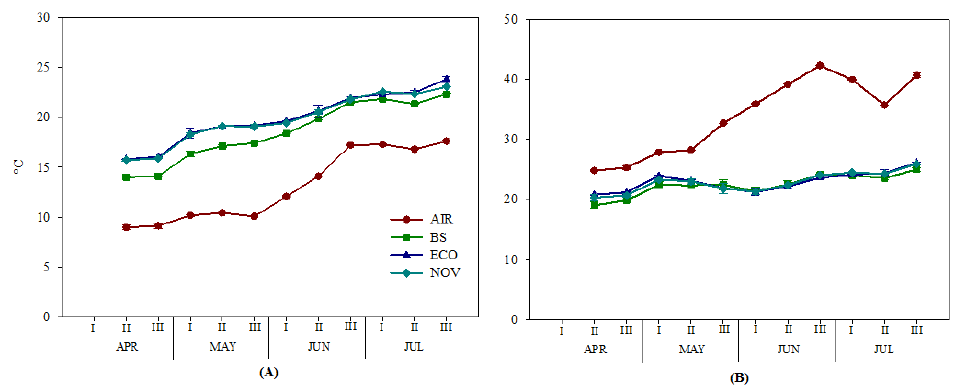
Figure 1. Pattern of the soil minimum ( A ) and maximum ( B ) average temperatures as affected by mulching (ECO: biodegradable film Ecovio; NOV: biodegradable film MaterBi ® ; BS: bare soil) compared to air temperature (Air). Vertical bars indicate standard error (n = 3).